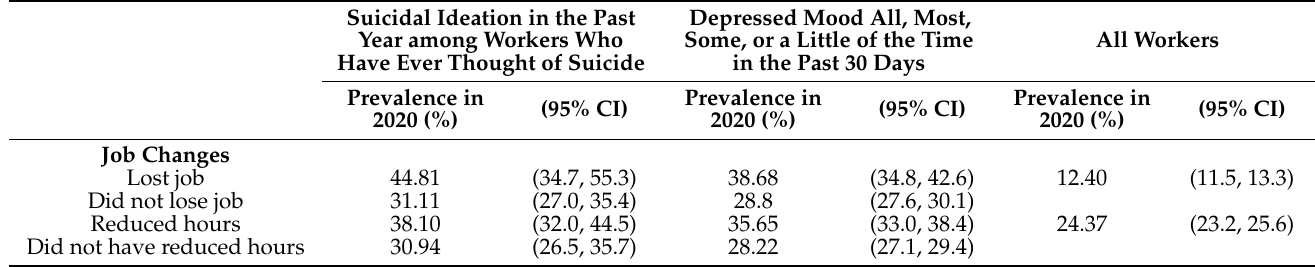
Table 3. Job loss and reduced hours among working adults in 2020. Suicidal Ideation in the Past Year among Workers